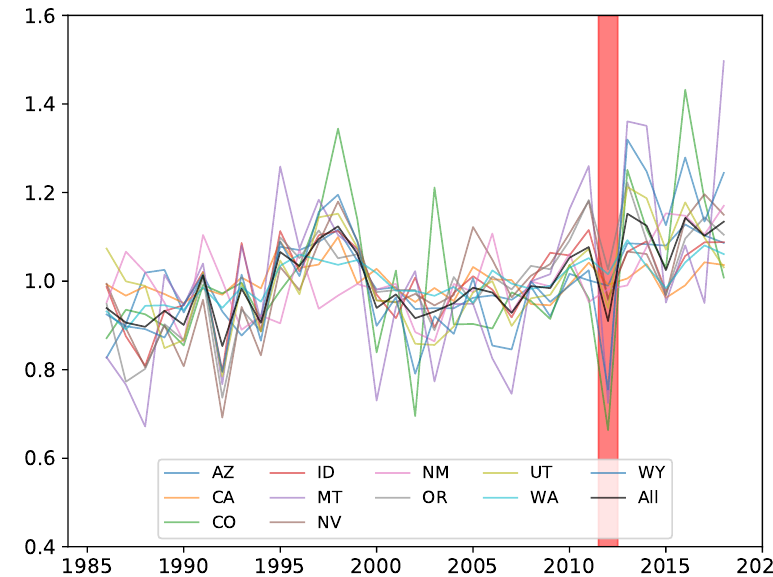
Figure 11. The statewide and study area sum of irrigated area predicted by IrrMapper over the 33-year study period, normalized to one. Highlighted is the year 2012, the only year in which the only available USGS atmospherically corrected Landsat surface reflectance data were impacted by the scan line corrector hardware failure on the Landsat 7 ETM+ mission.